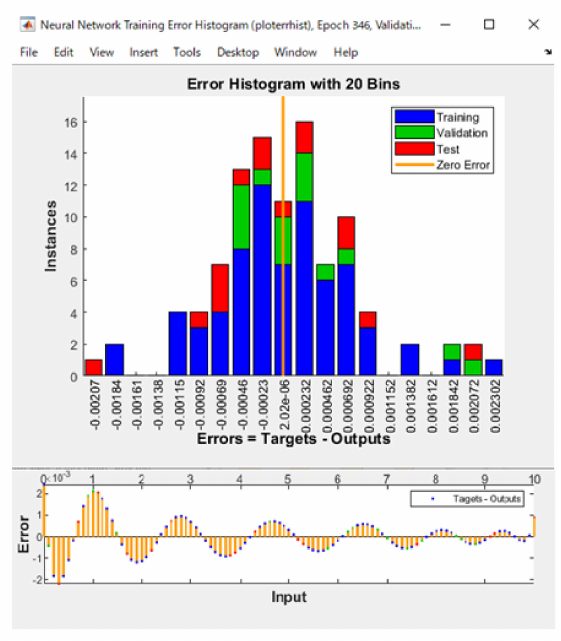
Figure 26. Evaluation of the training error Histogram for the proposed ANN